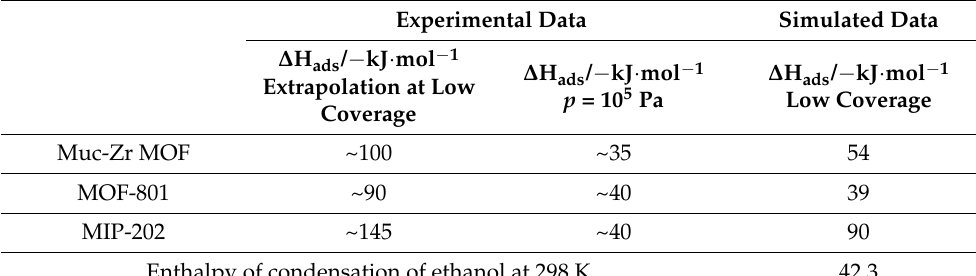
Figure 9. Ethanol sorption isotherms at 303 K by the prepared MOFs. (Red) Muc-Zr MOF, (green) MOF-801, (blue) MIP-202. ( Left ) Experimental data ( Right ) predicted data. Table 4. Enthalpies of adsorption of ethanol by the three